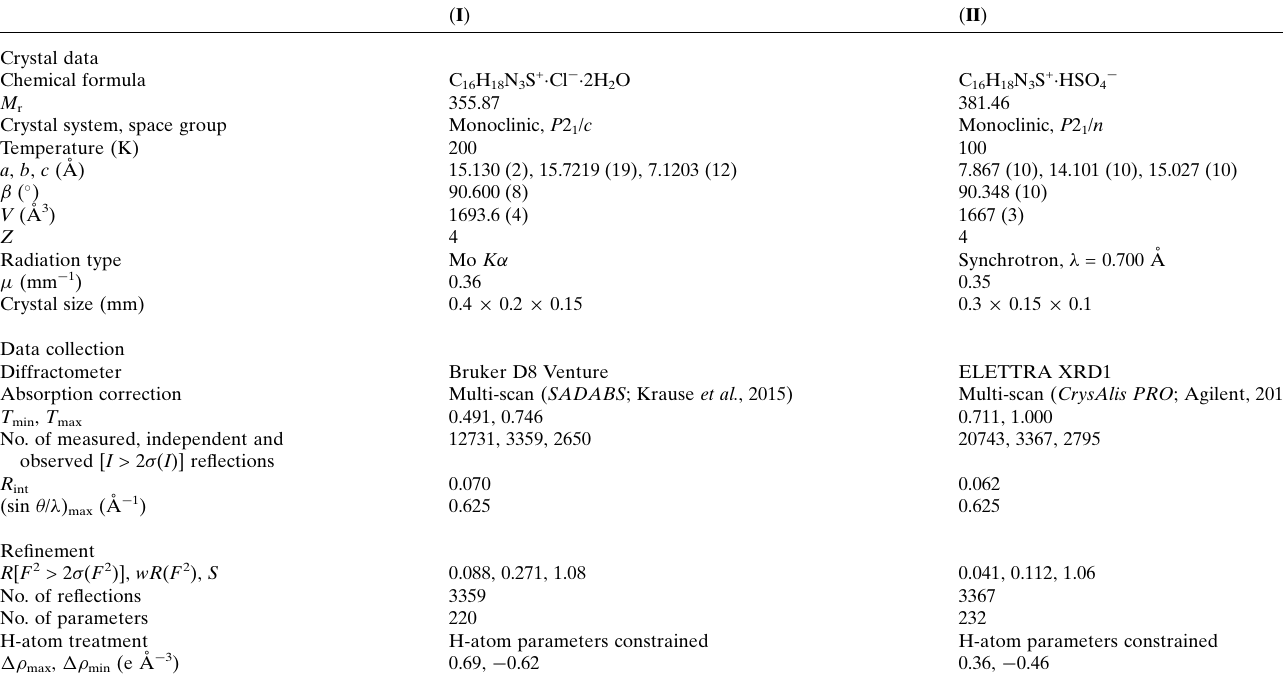
Table 3 Experimental details.